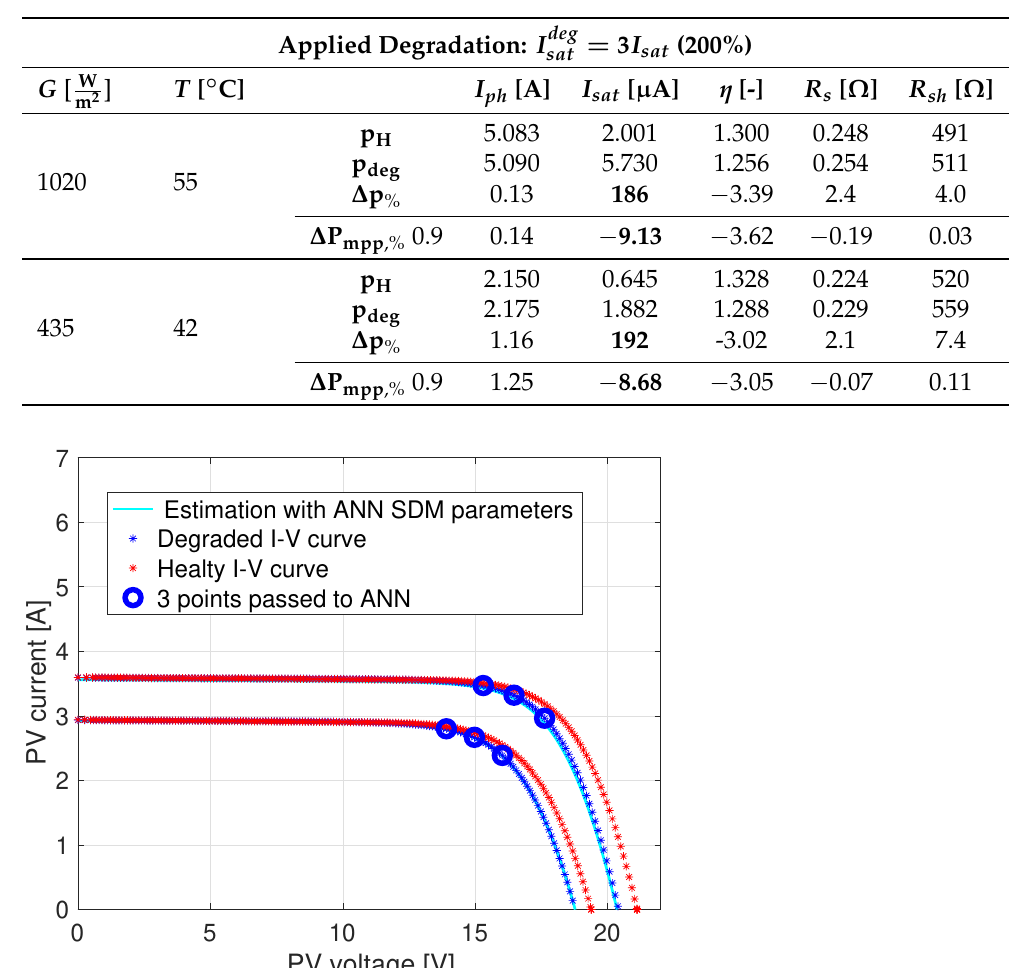
Table 6. SDM parameters estimated with ANN for I - V curves of Figure 14.